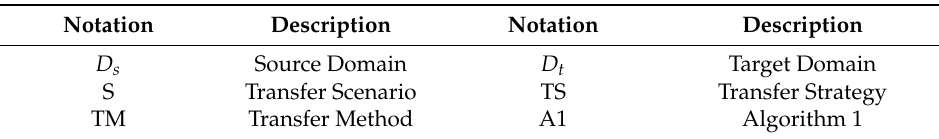
Table 1. Notations and